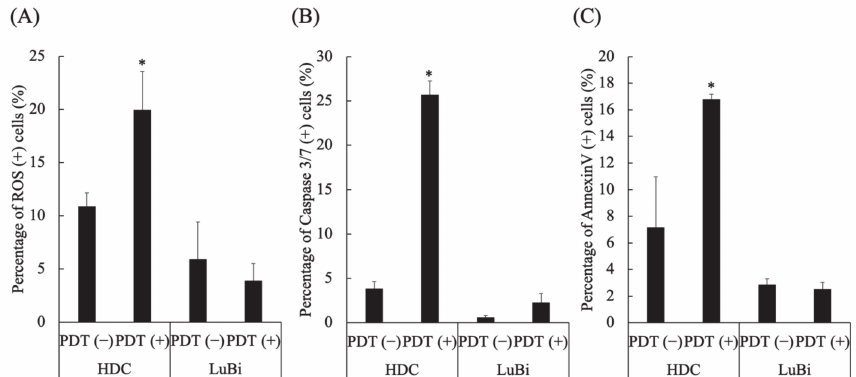
Figure 4. Analysis of apoptosis and reactive oxygen species (ROS) induced by 5-aminolevulinic acid- mediated photodynamic therapy (5-ALA-mediated PDT). ( A ) ROS induction by 5-ALA-mediated PDT. ( B ) Caspase 3/7 activation by 5-ALA-mediated PDT. ( C ) Apoptosis induction by 5-ALA- mediated PDT. Results are presented as mean ± standard deviation ( n = 4). Groups were compared using the Mann–Whitney test, * p < 0.05 vs. HDC PDT ( −